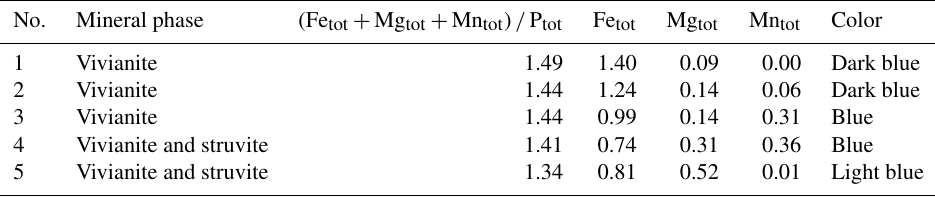
Table 3. Key characteristics of the synthesized phosphate minerals with molar iron (Fe), magnesium (Mg) and manganese (Mn) fractions in the precipitates relative to phosphorus (P). The mineralogy was investigated by X-ray diffraction (XRD) (Fig. 9a). No. Mineral phase (Fe tot + Mg tot + Mn tot ) / P tot Fe tot Mg tot Mn tot Color 1 1.49 1.40 0.09 0.00 Dark blue 1.44